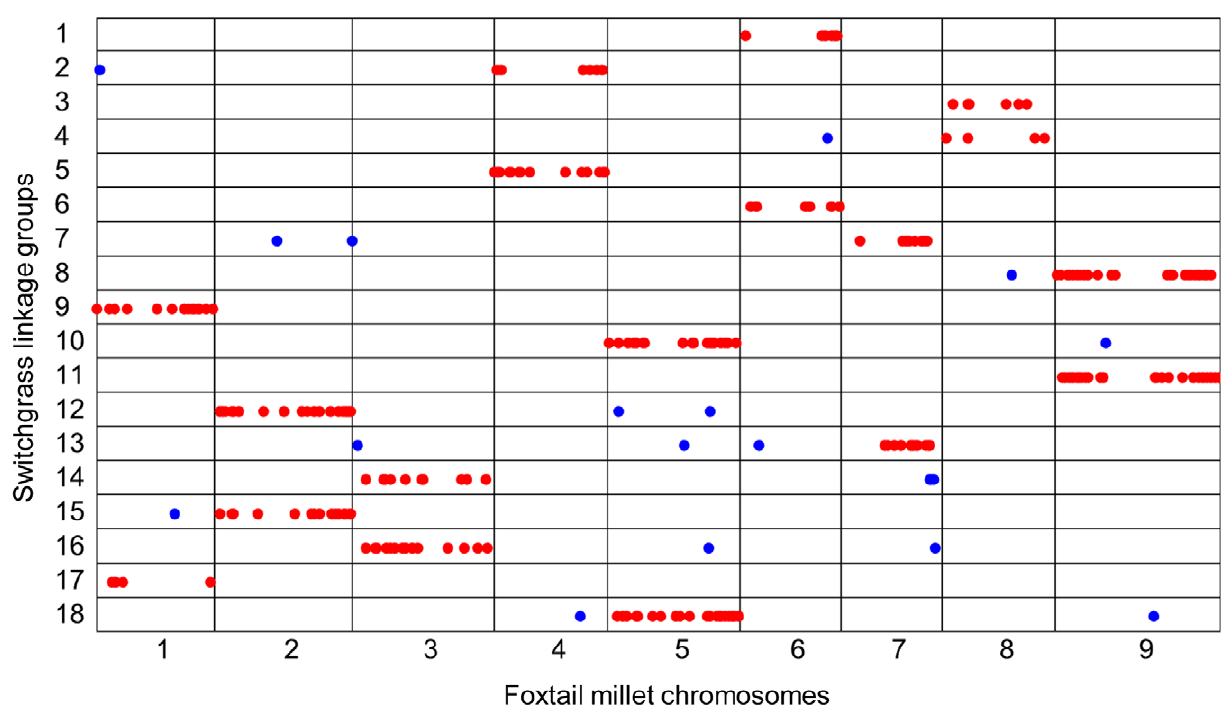
Figure 5. Sequence alignment of SNPs in switchgrass paternal linkage groups to the foxtail millet genome. Nearly 10% (299/3000) of the SNPs previously mapped to switchgrass linkage groups were also mapped to unique sites in the foxtail millet genome. For each linkage group, the majority of SNPs that aligned to one chromosome of the foxtail millet genome are labeled red; the few exceptions are in blue. Each foxtail millet chromosome matches two switchgrass linkage groups, clearly indicating a genome duplication.